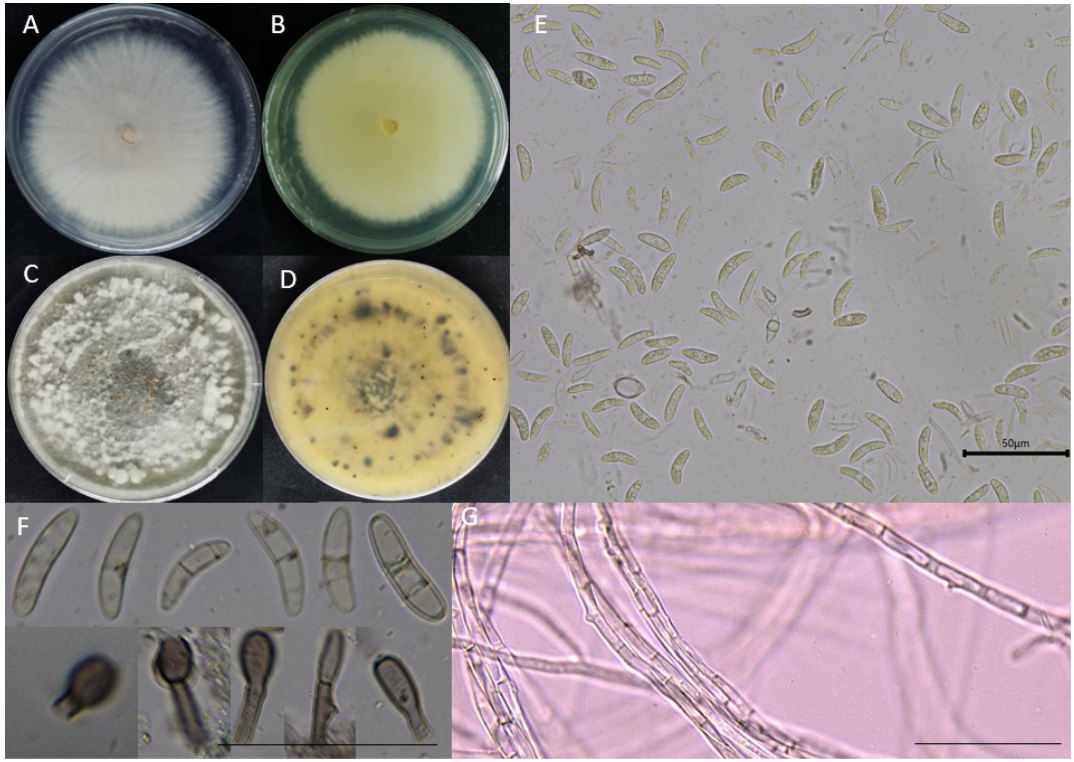
Figure 2. The morphology of mycelia and fungal spores grown on PDA medium for 14 days. ( A , C ) Front of the colony; ( B , D ) back of colony; ( E , F ) conidia and sporophore; ( G ) hyphae. The scale bars in Figure 2E–G are all 50 µm.